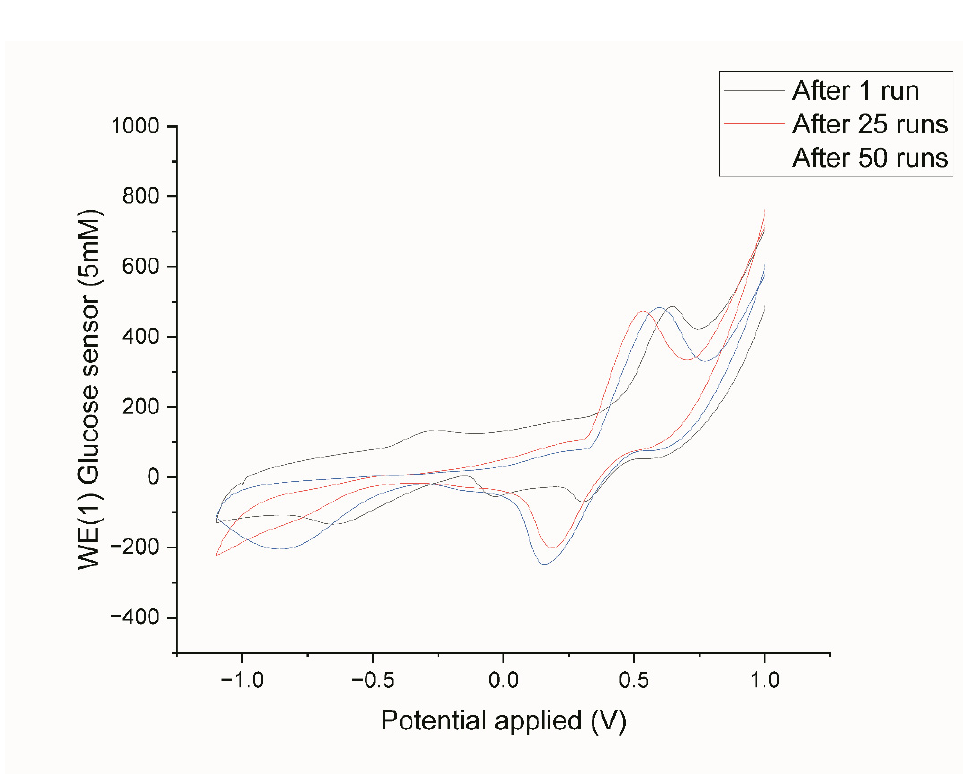
Figure 13. CVs of Au-Ni/AC SPE after 1, 25, and 50 times of amperometric tests in 5 mM glucose in 0.1 M NaOH.